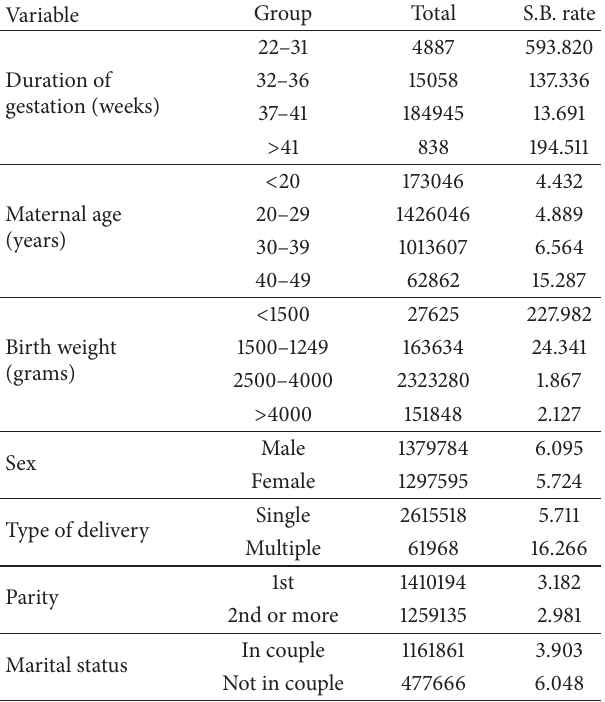
Table 2: Stillbirth rates × 1000 (S.B.) by category group for each variable studied